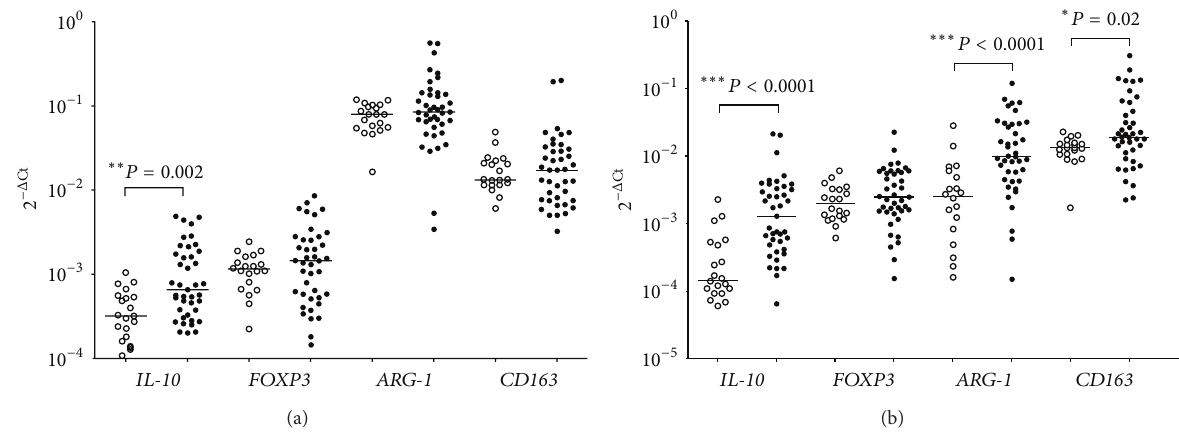
Figure 1: Expression of IL-10, FOXP3 , ARG-1, and CD163 mRNA in BM (a) and PB (b) samples from 41 high-risk NB patients (black circles) and 20 healthy controls (empty circles). Data are expressed as 2 −Δ Ct values. Horizontal bars indicated medians. 𝑃 values are indicated where differences are